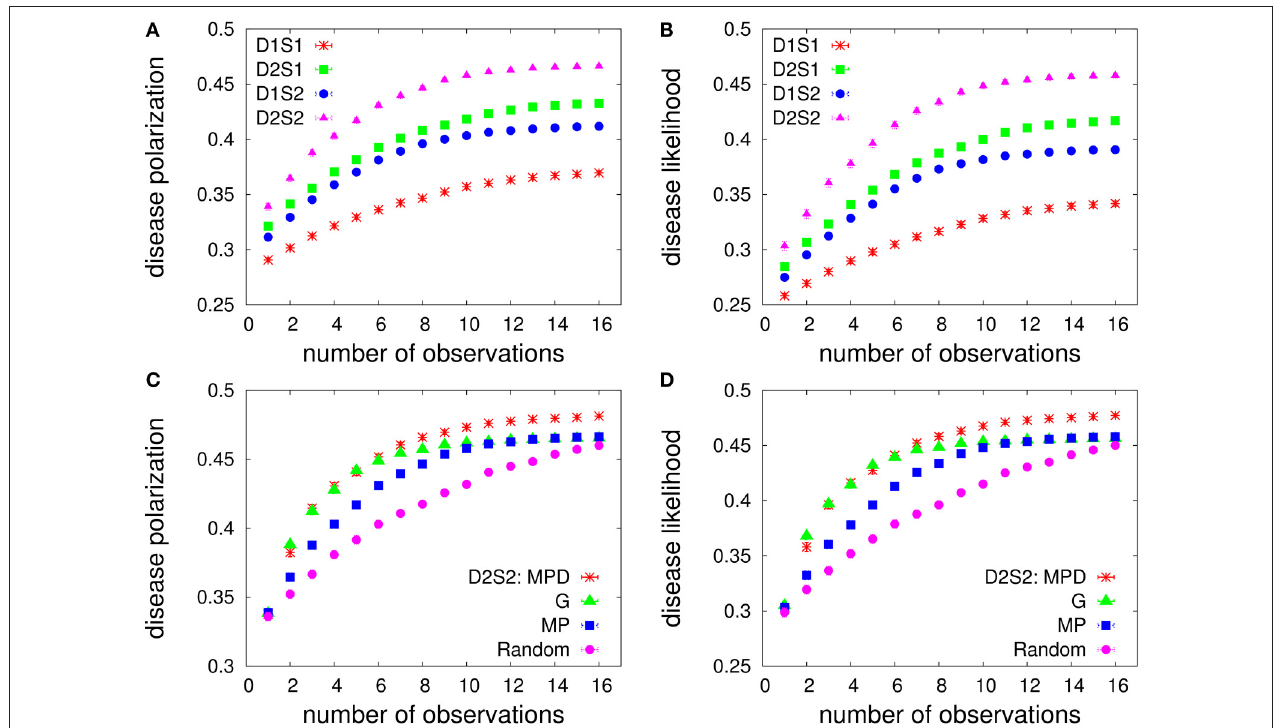
FIGURE 4 | Diagnostic performance of the models vs. the number of observations for a small number of sign/disease variables. (Top) The exact disease-polarization (A) and disease-likelihood (B) obtained by the MP strategy in the one-disease-one-sign ( D 1 S 1), two-disease-one-sign ( D 2 S 1), one-disease-two-sign ( D 1 S 2), and two-disease-two-sign ( D 2 S 2) models. There are N D couplings in the interaction factors are iid random numbers distributed uniformly in the specified intervals: K 0 i (Bottom) Comparing the exact polarization (C) and likelihood (D) of the diseases obtained by the MP, greedy (G), MPD, and random strategies, for the D 2 S 2 model. The data are results of averaging over 1,000 independent realizations of the model